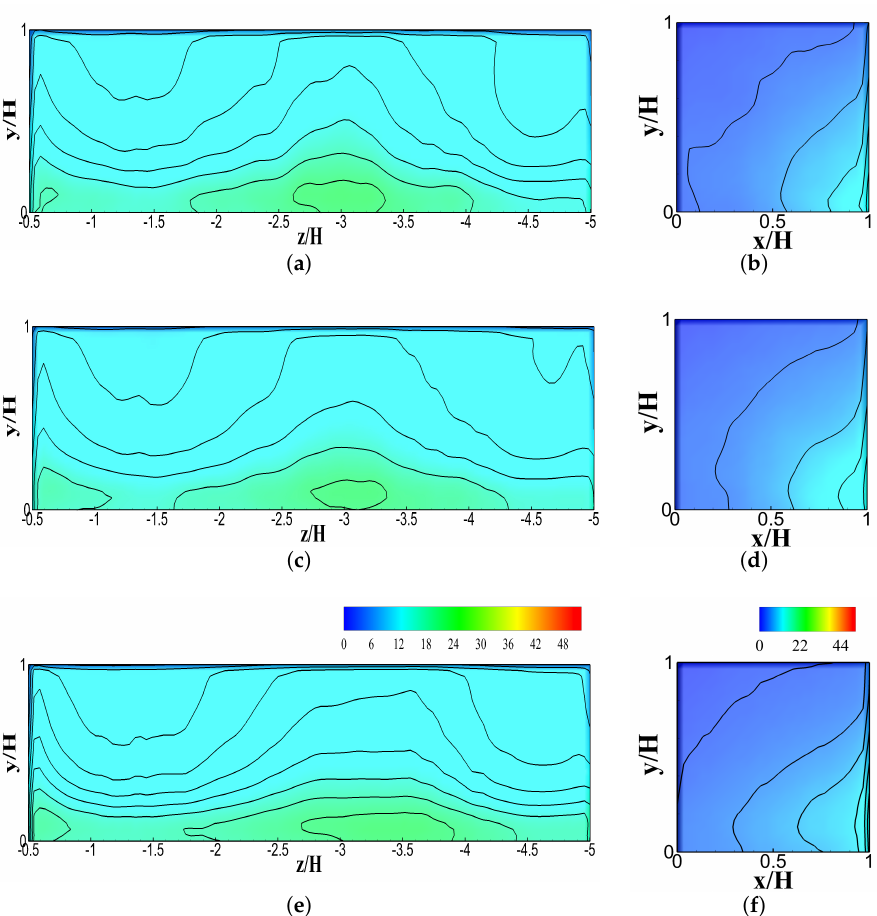
+ (cid:105) data on Building B (upwind